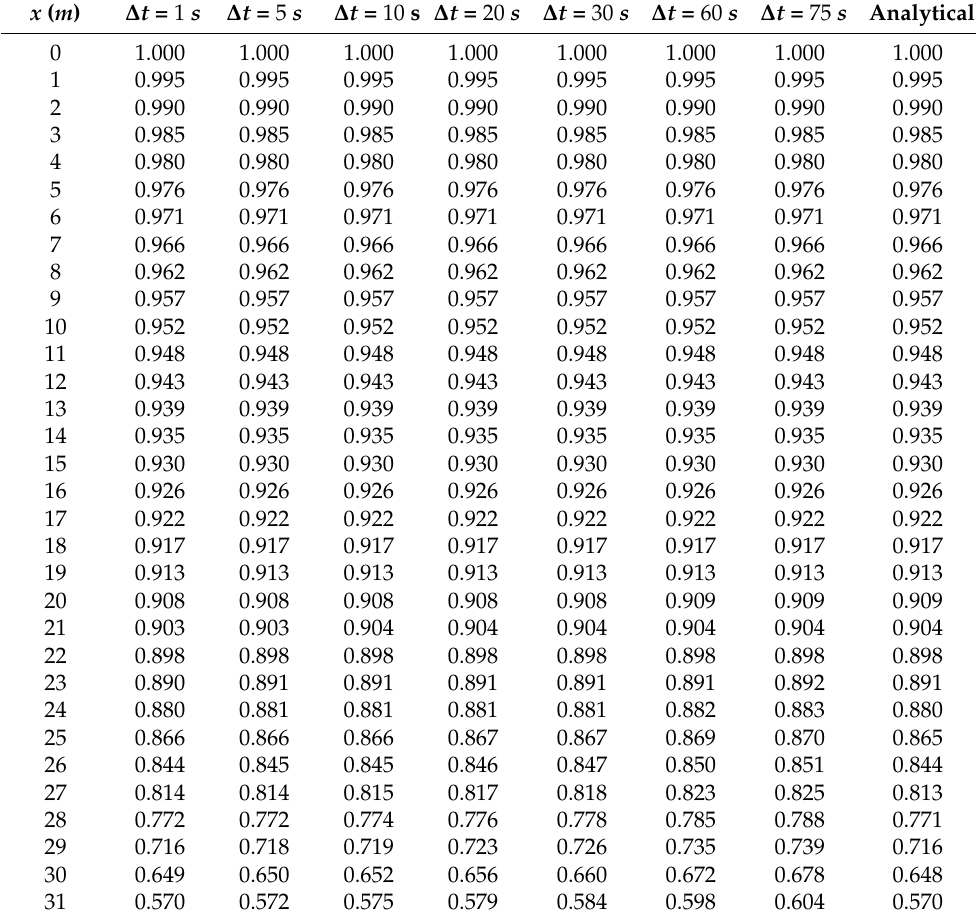
Table 4. Comparison of the analytical solution with the numerical results of the ERK4-NCCD scheme for different time steps ∆ t and ∝ = 0.005 m − 1 at t = 3000 s.